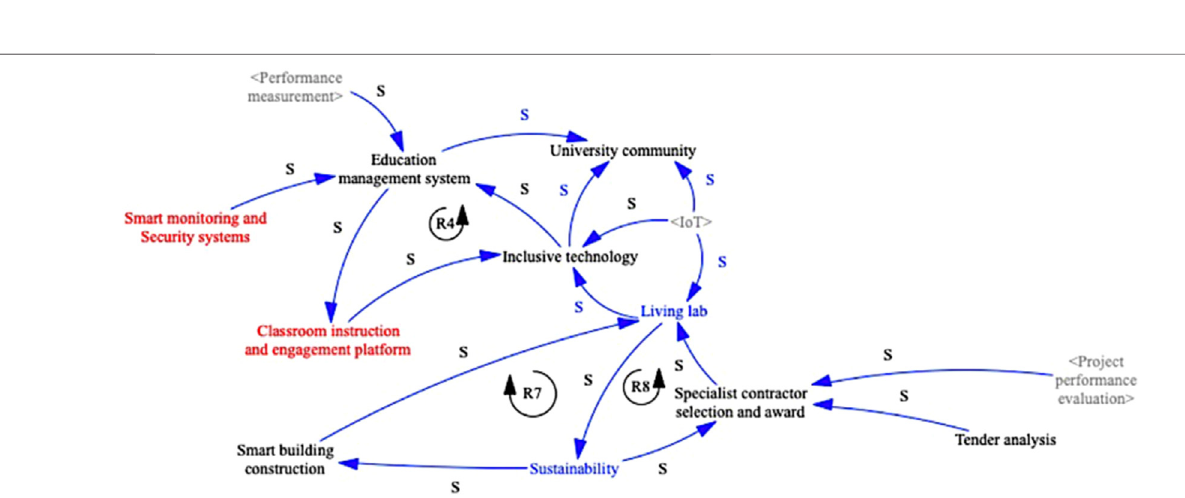
Frontiers in Built Environment |